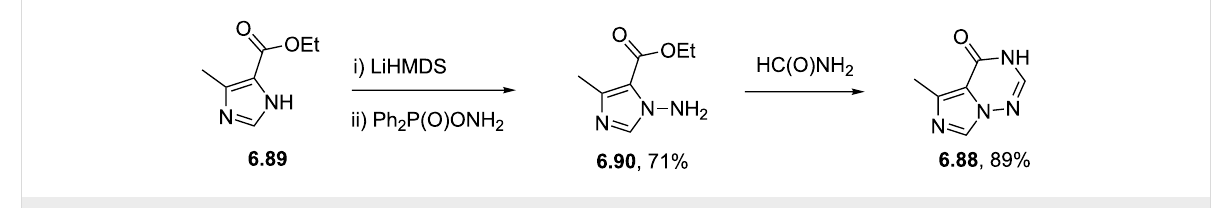
Scheme 62: Short route to